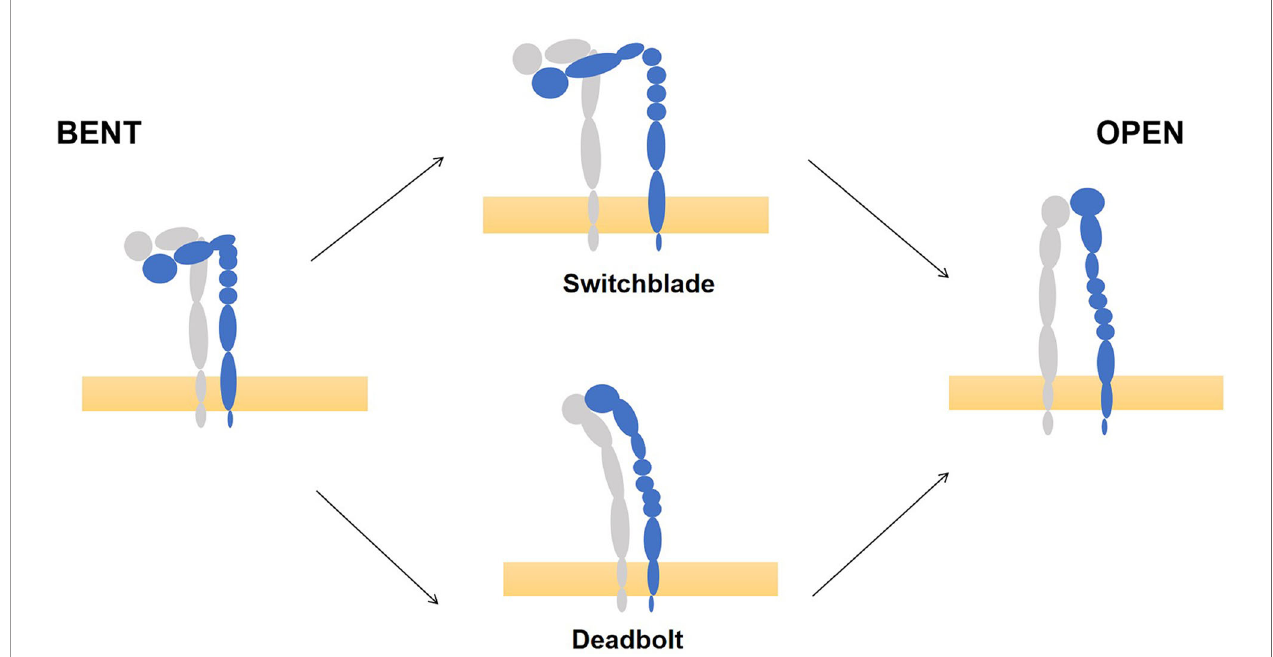
FIGURE 2 | Models of integrin conformational activation. Take integrin a V b 3 for example, there are two common models for activation of integrins, the ‘‘ switchblade ’’ and the ‘‘ deadbolt ’’ models, to describe a transition state from the low af fi nity state (left) and high af fi nity state (right). (This picture modi fi ed from Bidone TC. Coarse-Grained Simulation of Full-Length Integrin Activation. Biophys J. 2019 Mar 19;116 (6):1000-1010. doi: 10.1016/j.bpj.2019.02.011. Epub 2019 Feb